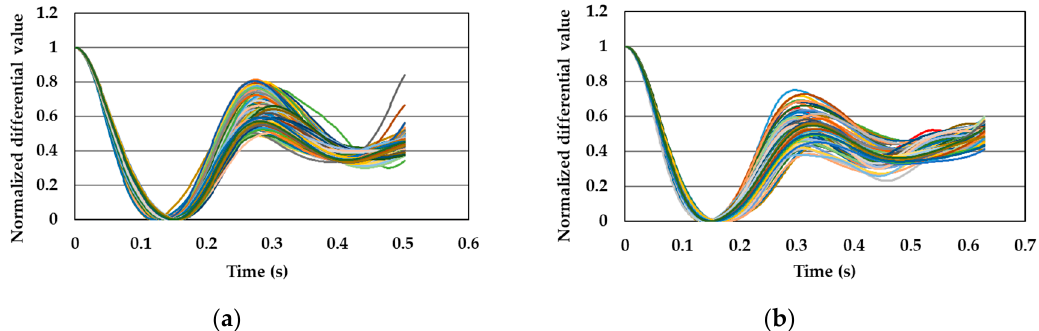
Figure 14. Normalized pulse wave signals: ( a ) subject A and ( b ) subject B.